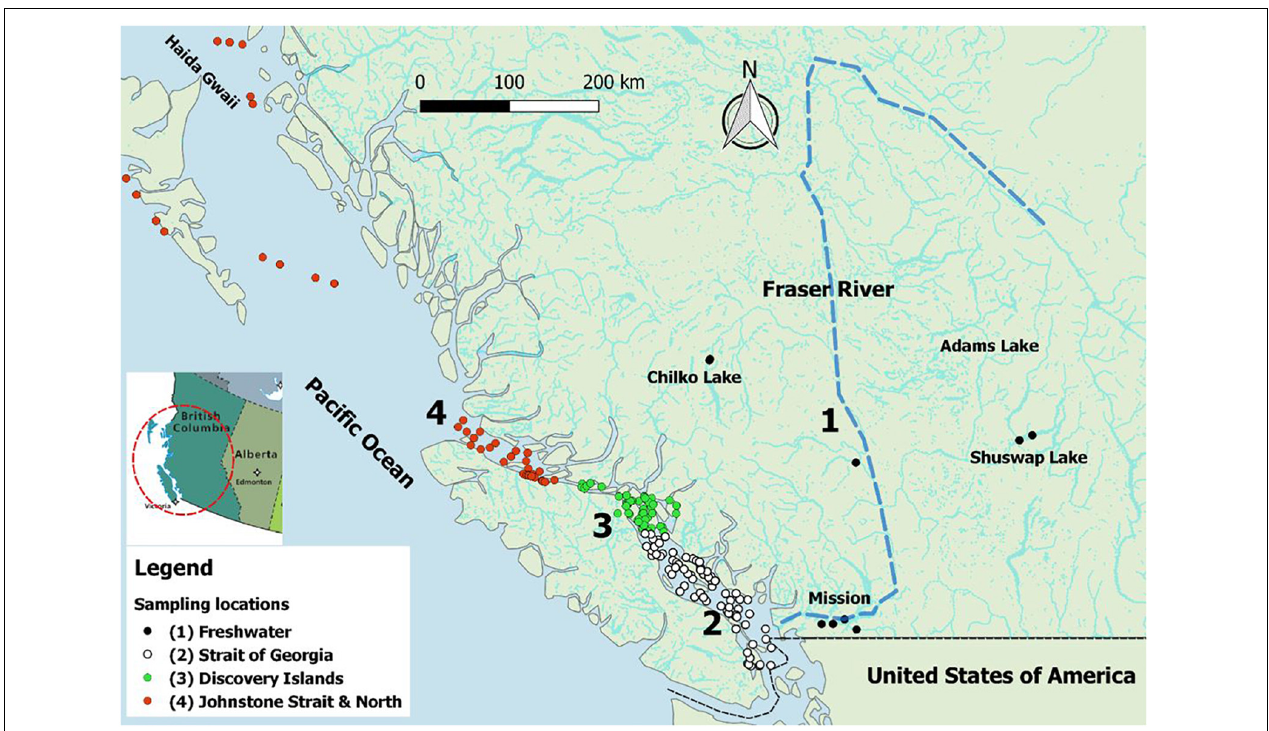
FIGURE 1 | Map of British Columbia (BC), Canada, illustrating the Fraser River watershed (the main stream is dashed) and the four sampling regions from which 2,006 juvenile Fraser River Sockeye smolts were collected for this study. The out-migration route is from ‘Region 1’ to ‘Region 4.’ This map was created in QGIS v2.18.13